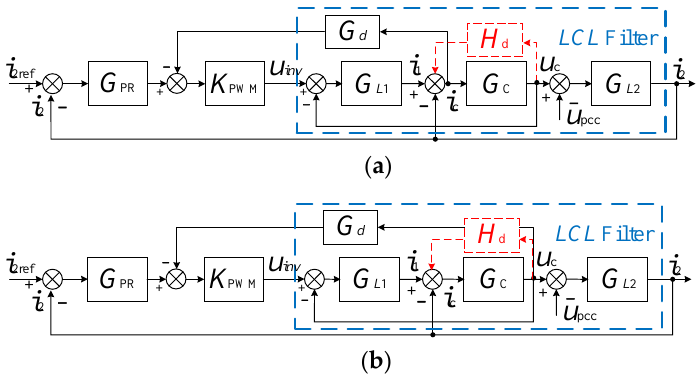
Figure 15. Equivalent control diagram. ( a ) Capacitor current feedback; ( b ) Capacitor voltage feedback.